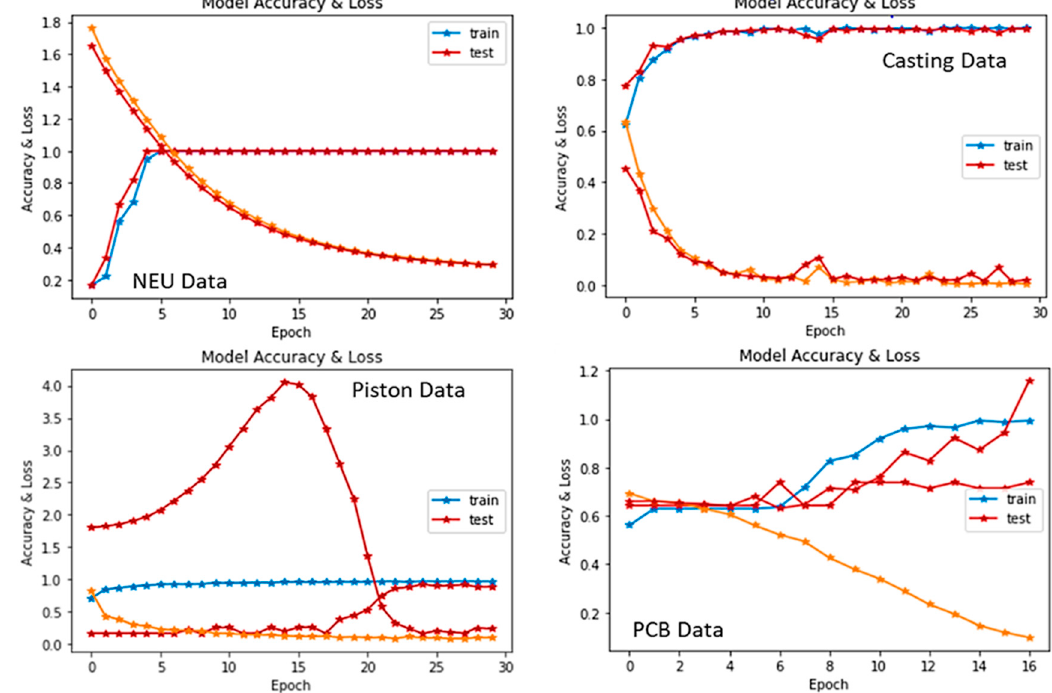
Figure 6. The output summary of the model training and testing process with the datasets.